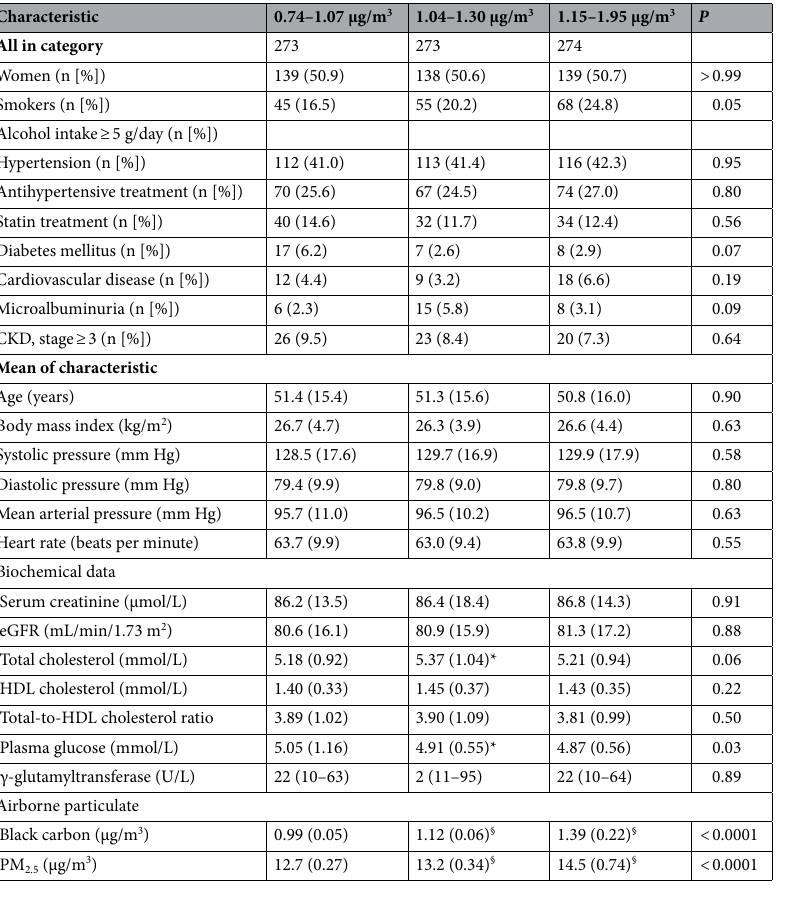
Table 1. Baseline characteristics of participants by thirds of the black carbon distribution. CKD, chronic kidney disease; eGFR, glomerular filtration rate estimated from serum creatinine by the CKD-EPI formula; HDL, high-density lipoprotein. Microalbuminuria (> 3.5/> 2.5 mg per mmol creatinine in women/men) was available in 780 participants. Thirds of the black carbon distribution were determined after stratification for sex and age (< 50, 50–64, ≥ 65 years). Blood pressure was the average of five consecutive auscultatory readings. Hypertension was a blood pressure of ≥ 140 mm Hg systolic or ≥ 90 mm Hg diastolic, or use of antihypertensive drugs. Diabetes mellitus was a fasting plasma glucose of > 7.0 mmol/L (> 126 mg/dL) or use of antidiabetic agents. The central tendency (data spread) is given as arithmetic mean (SD) or median (5th–5th percentile interval). P-values were derived by Fisher exact test, ANOVA or the Kruskal–Wallis test. Significance of the difference with the adjacent lower third: * P ≤ 0.05; § P ≤